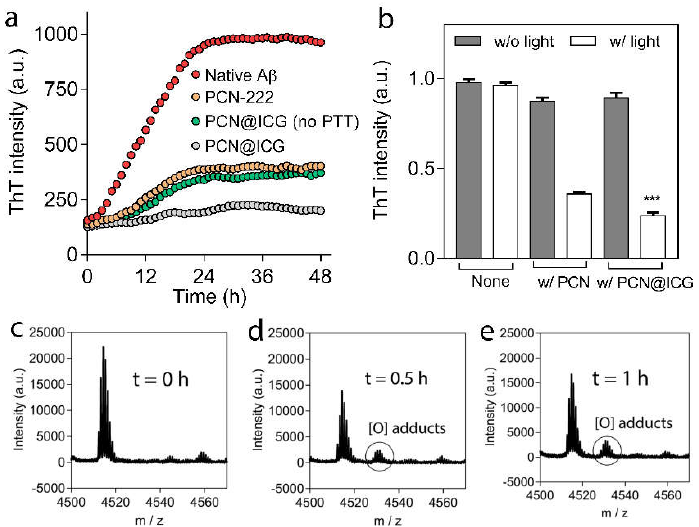
Figure 5. ( a ) Thioflavin T (ThT) assay for various groups of A β 42 monomers with NIR laser treatment using PCN − 222, PCN-222@ICG excluding photothermal effect (no PT), PCN − 222@ICG, and native Aβ 42 monomers without nanoprobes. ( b ) Relative ThT fluorescence signals of various groups at 48 h for native Aβ 42 with/without NIR irradiation as control groups, native Aβ 42 in the presence of PCN−222 with/without NIR irradiation, and native Aβ 42 in the presence of PCN−222@ICG without NIR irradiation, with NIR irradiation, and with NIR irradiation but excluding photothermal effects (no PT). One-way ANOVA with Student’s t-test was used in the analysis. Each experiment had triplicates and was performed three times independently (for above diagrams, NIR laser irradiation is 808 nm with a power density of 0.6 W cm −2 ), ***p<0.001. MALDI-TOF MS spectra of the Aβ 42 samples of native Aβ 42 monomers ( c ) without nanoprobe treatment, ( d ) after treatment with photo- activated PCN − 222 excluding photothermal effect, and ( e ) after treatment with photo-activated PCN −